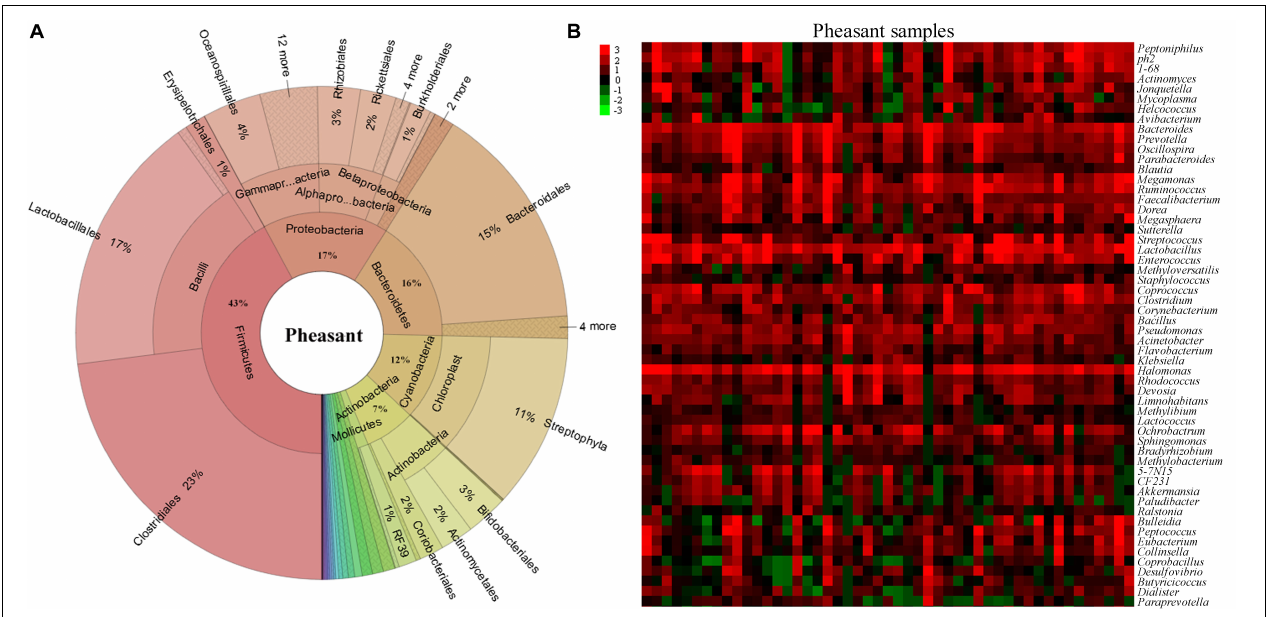
FIGURE 1 | Aggregate gut microbiota composition. (A) The distribution of the pheasant gut microbiota. (B) Heatmap of the pheasant gut microbiota at the genus level. Colors reflect relative abundance from low (green) to high